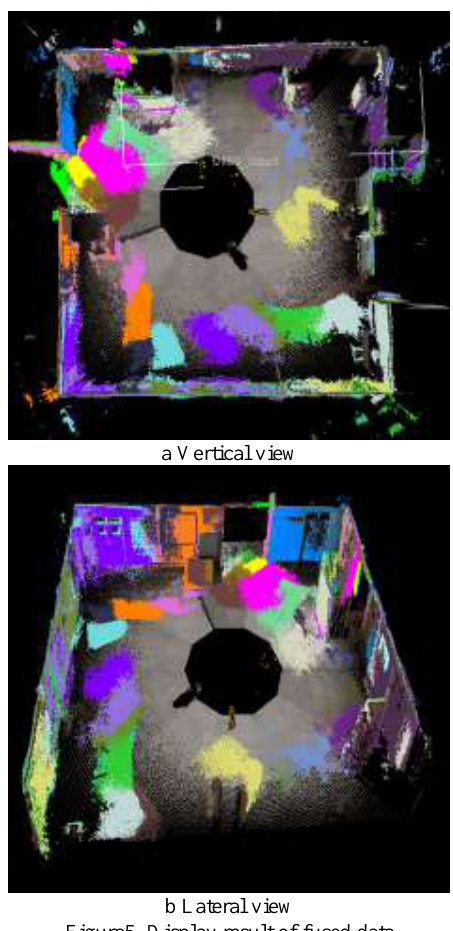
Figure5. Display result of fused